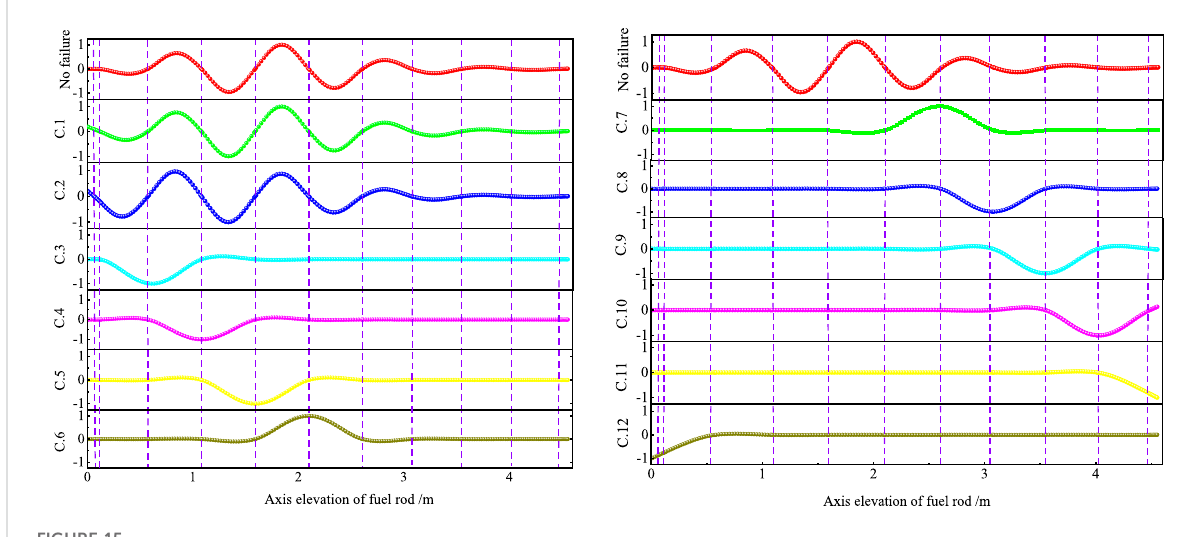
FIGURE 15 1-order vibration mode under clamping